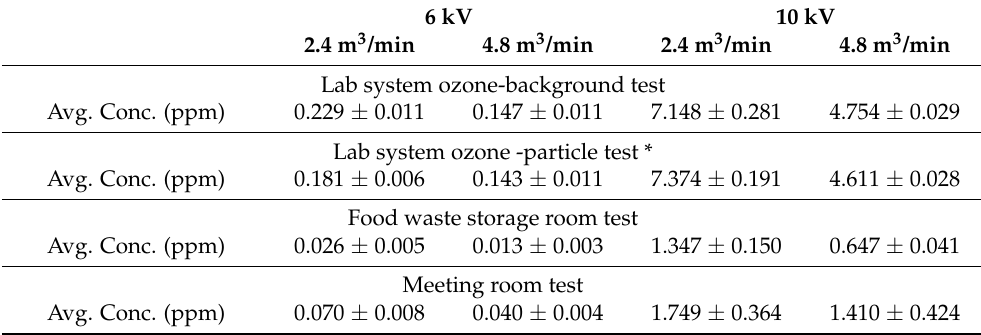
Table 3. Ozone generated by lab system test and field